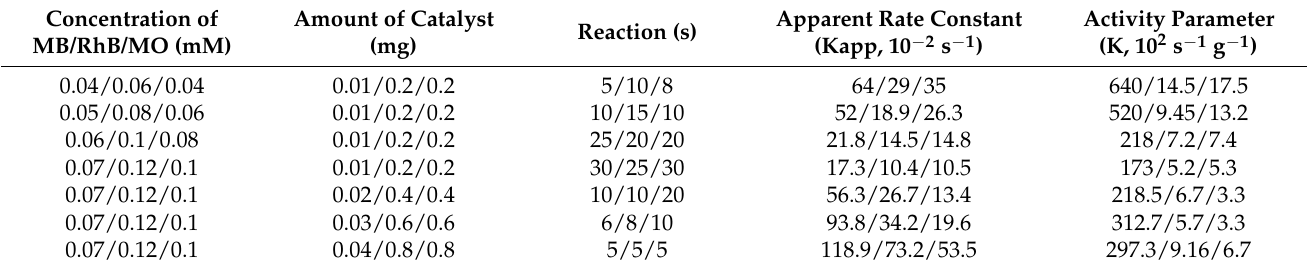
Figure 3. UV-vis spectrum of 2.5 mL (0.07 mM) MB degraded by Pd-Cu alloy NPs (0.01 mg) with different precursor proportions ( a – i ) in the presence of 0.1 mL (0.2 M) of NaBH 4 . Table 1. Summary of Reaction Time (s), Apparent Rate Constant (K app ) and Activity Parameter (K) for Degradation of MB/RhB/MO with Different Concentration and Catalytic